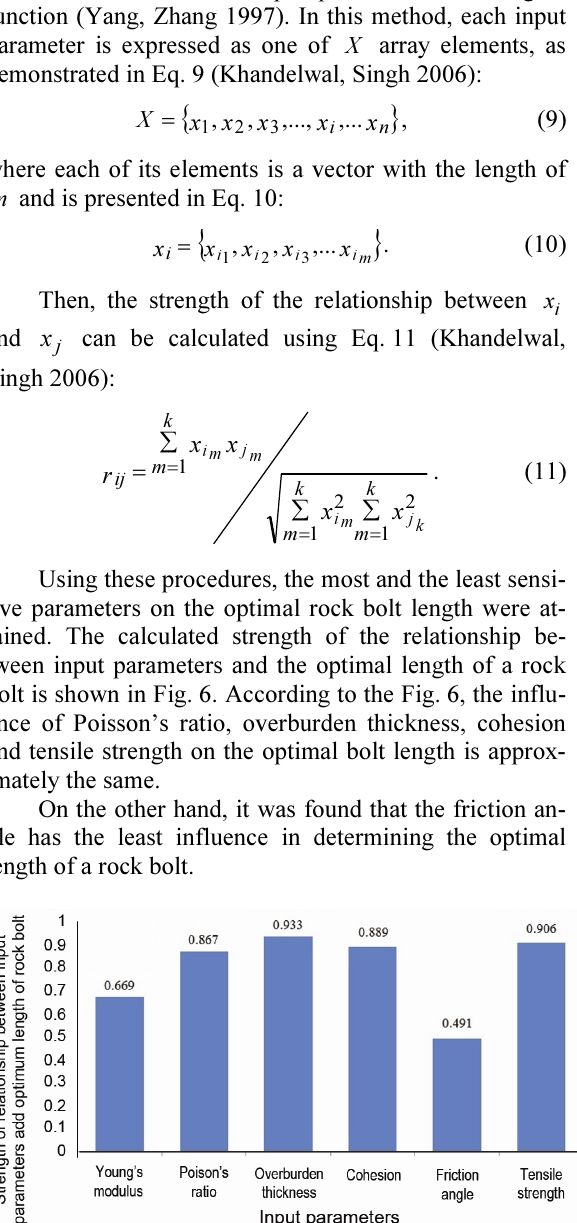
Fig. 5. Correlation between computed and predicted optimal bolt length for the optimal model, 6-18-3-1